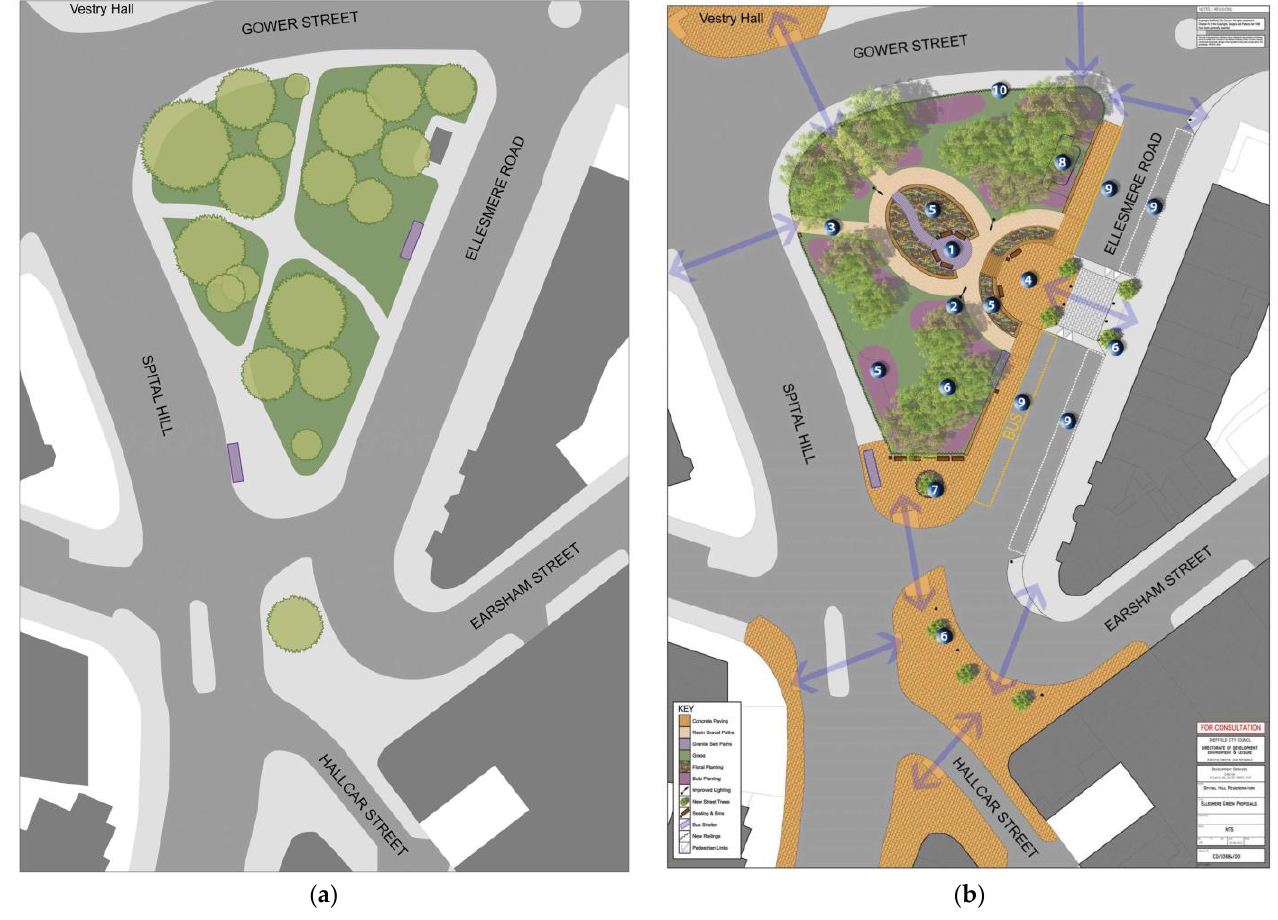
Figure 3. ( a ) The Old Ellesmere Green (2012). ( b ) The Current Ellesmere Green. © Burngreave Mes- senger Issue 101, August 2012).